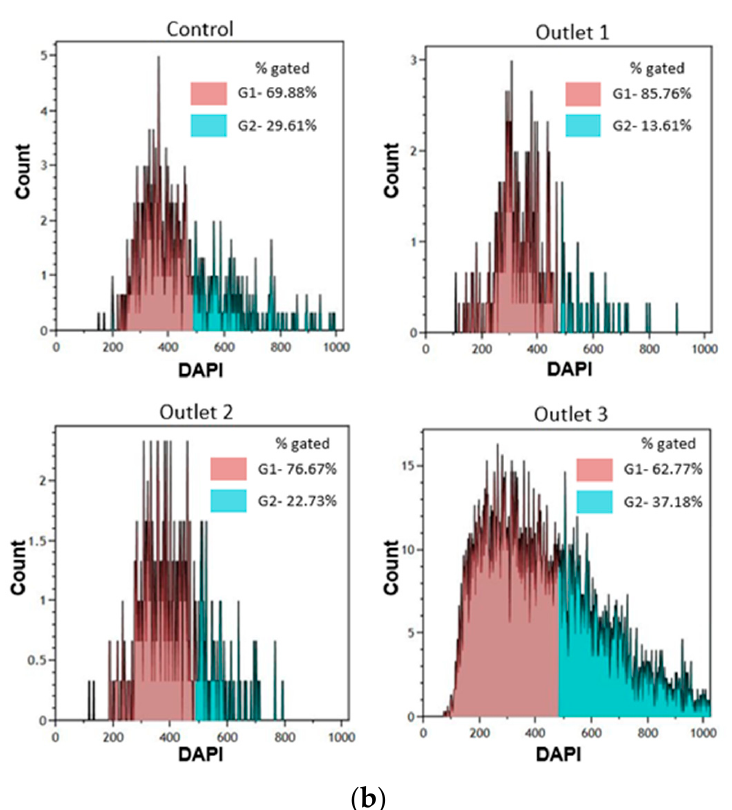
Figure 8. Representative results of the cell cycle synchronization. Flow conditions were 600 μ L·min − 1 , 1:4 ratio and σ = 0.21. ( a ) Bright field images show cells exiting through outlets 1 and 2. Scale bar is 100 µ m. ( b ) 4’,6-diamidino-2-phenylindole (DAPI) area analysis of cells shows increase of G1 phase in outlets 1 and 2 and an increase in G2 phase in outlet 3 as compared to the control.